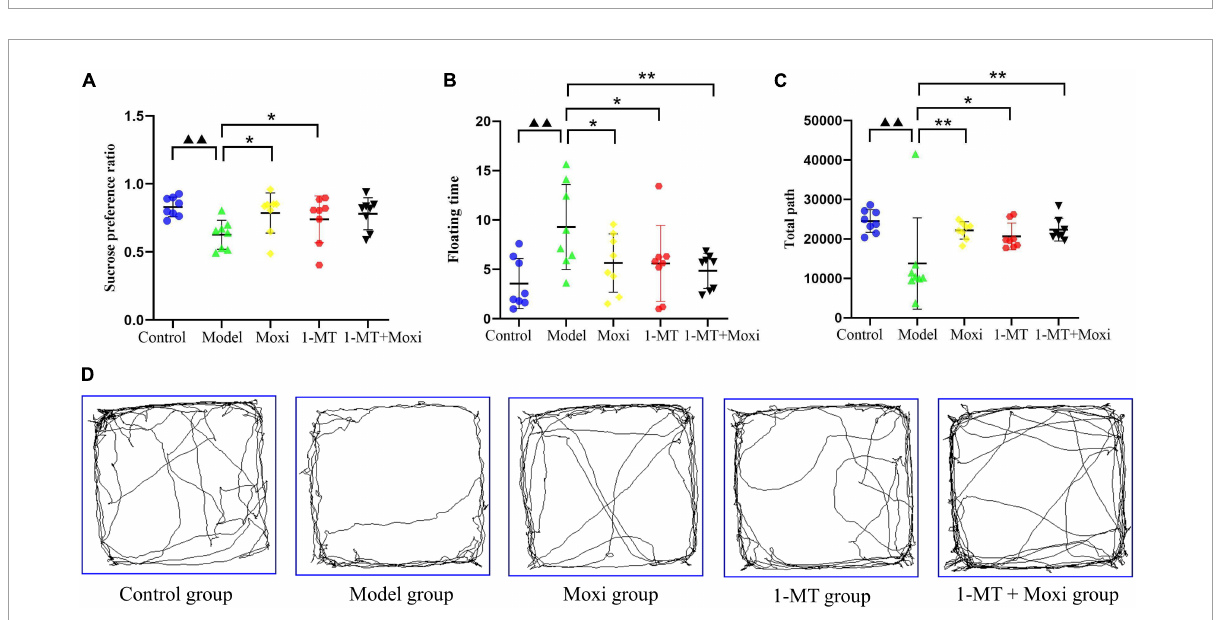
FIGURE6 Effects of moxibustion, 1-MT, or a combination of both on alleviating depression-like behavior. (A) Sucrose preference ratio, (B) Floating time of rats in each group; (C) Total path, and (D) Activity trajectory of rats in the open field experiment of rats in each group. n = 8 per group. (cid:78)(cid:78) P < 0.01 vs. control group; * P < 0.05, ** P < 0.01 vs. model